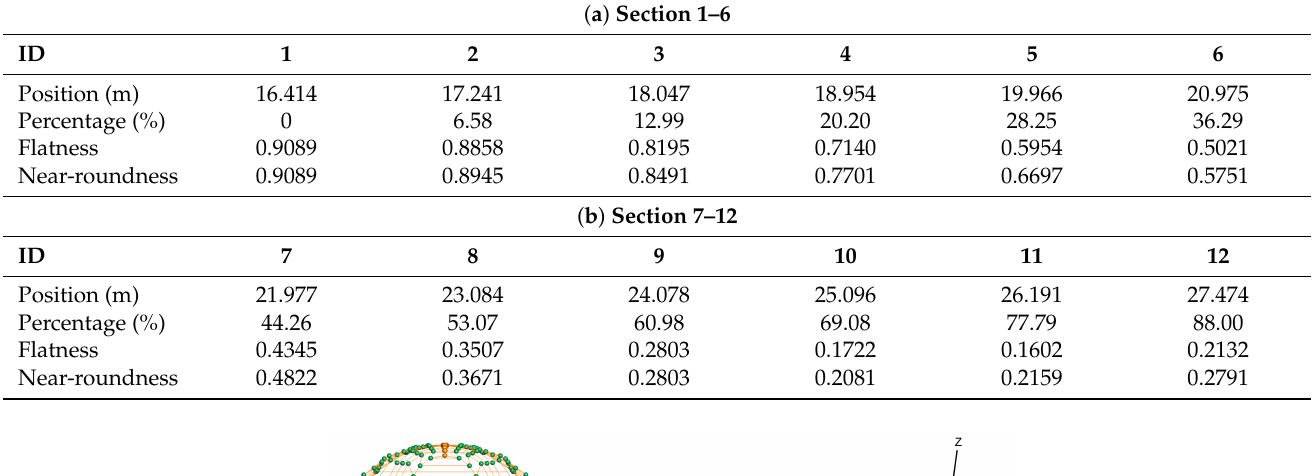
Table 3. Monitored sections for military transport aircraft optimization.